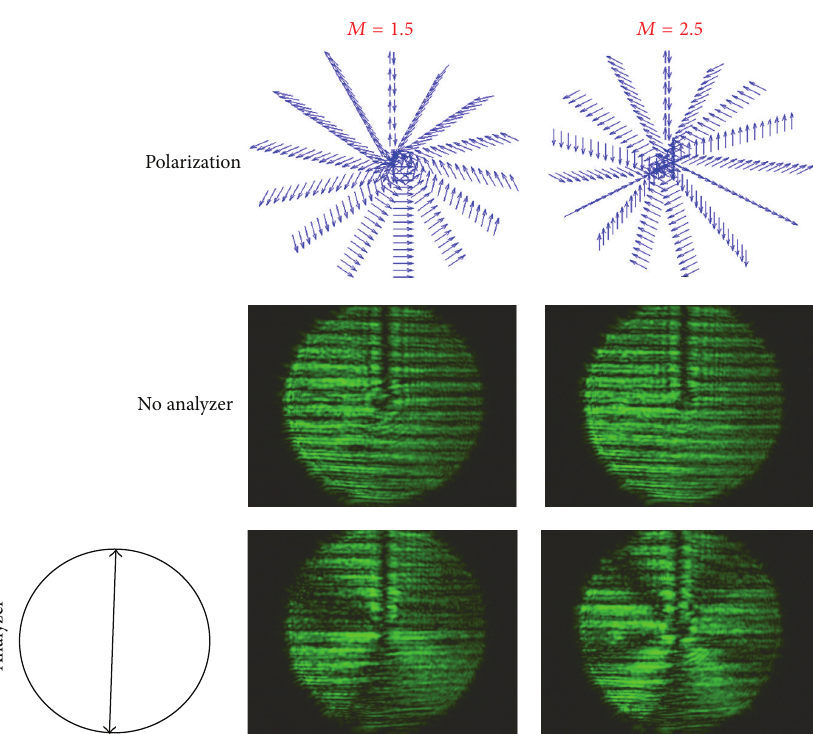
Figure 4: Cylindrical vector beams generated for a noninteger topological charge 𝑀 = 1.5 and 𝑀 = 2.5 and constant phase difference of 𝜓 = 0 for both.